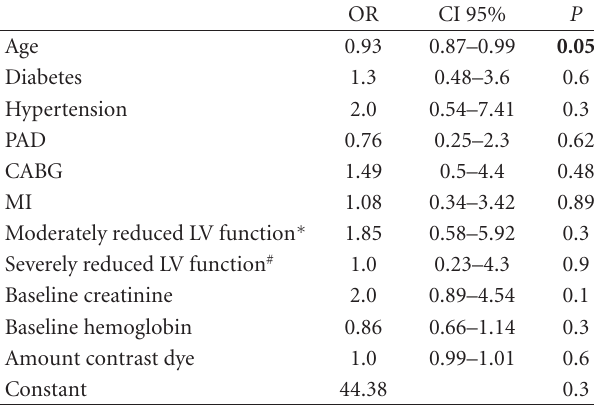
Figure 2: Morbidity and mortality with respect to access site and development of acute kidney injury (AKI): observed 30-day mortality and predicted renal failure and mortality by STS Score for pts. with and without AKI; AKI = acute kidney